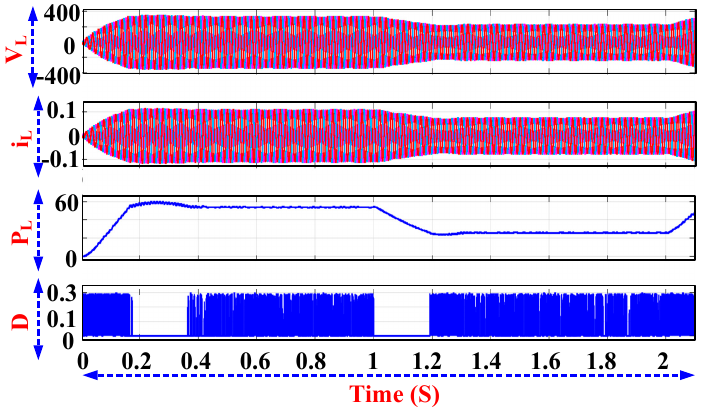
Figure 16. Output of Z-Source inverter with PSO based Maximum Power Point Tracking (MPPT).